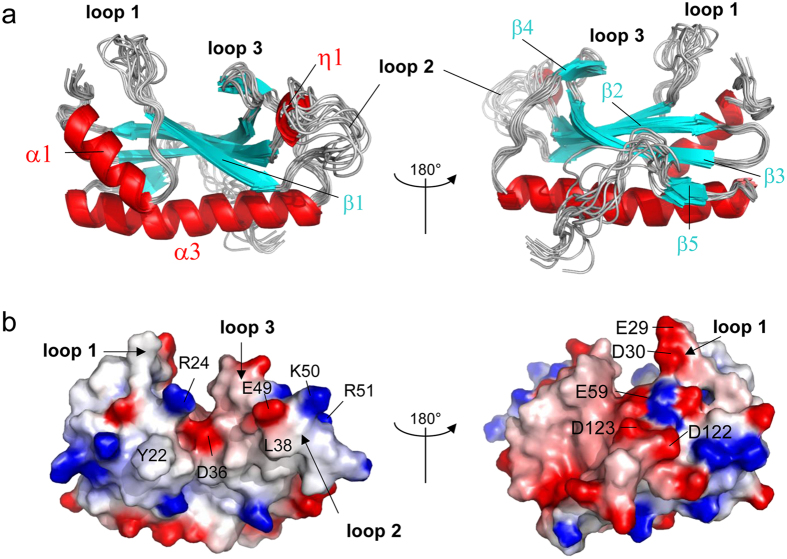
NMR structure of S. Typhimurium Crl.(a) Backbone ensemble structure of CrlSTM showing the 10 final low-energy conformers with the lowest CYANA target function in cartoon representation. Secondary structure elements are annotated using the numbering of CrlPM18. The two views are rotated by 180°. (b) The electrostatic surface potential was calculated with Delphi44 using the conformer 1. Colours are red to blue for acidic to basic potential. Critical residues, including D36, which delineate the entrance of the cavity, are indicated.